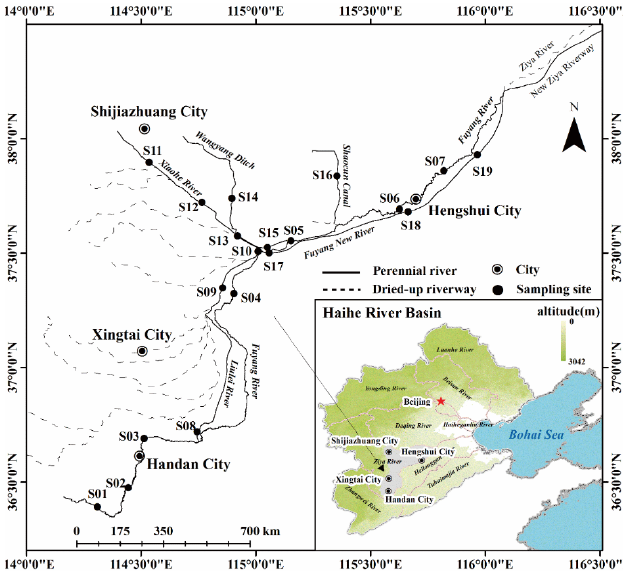
Figure 1. Sample sites in the plains region of the Ziya River Watershed.